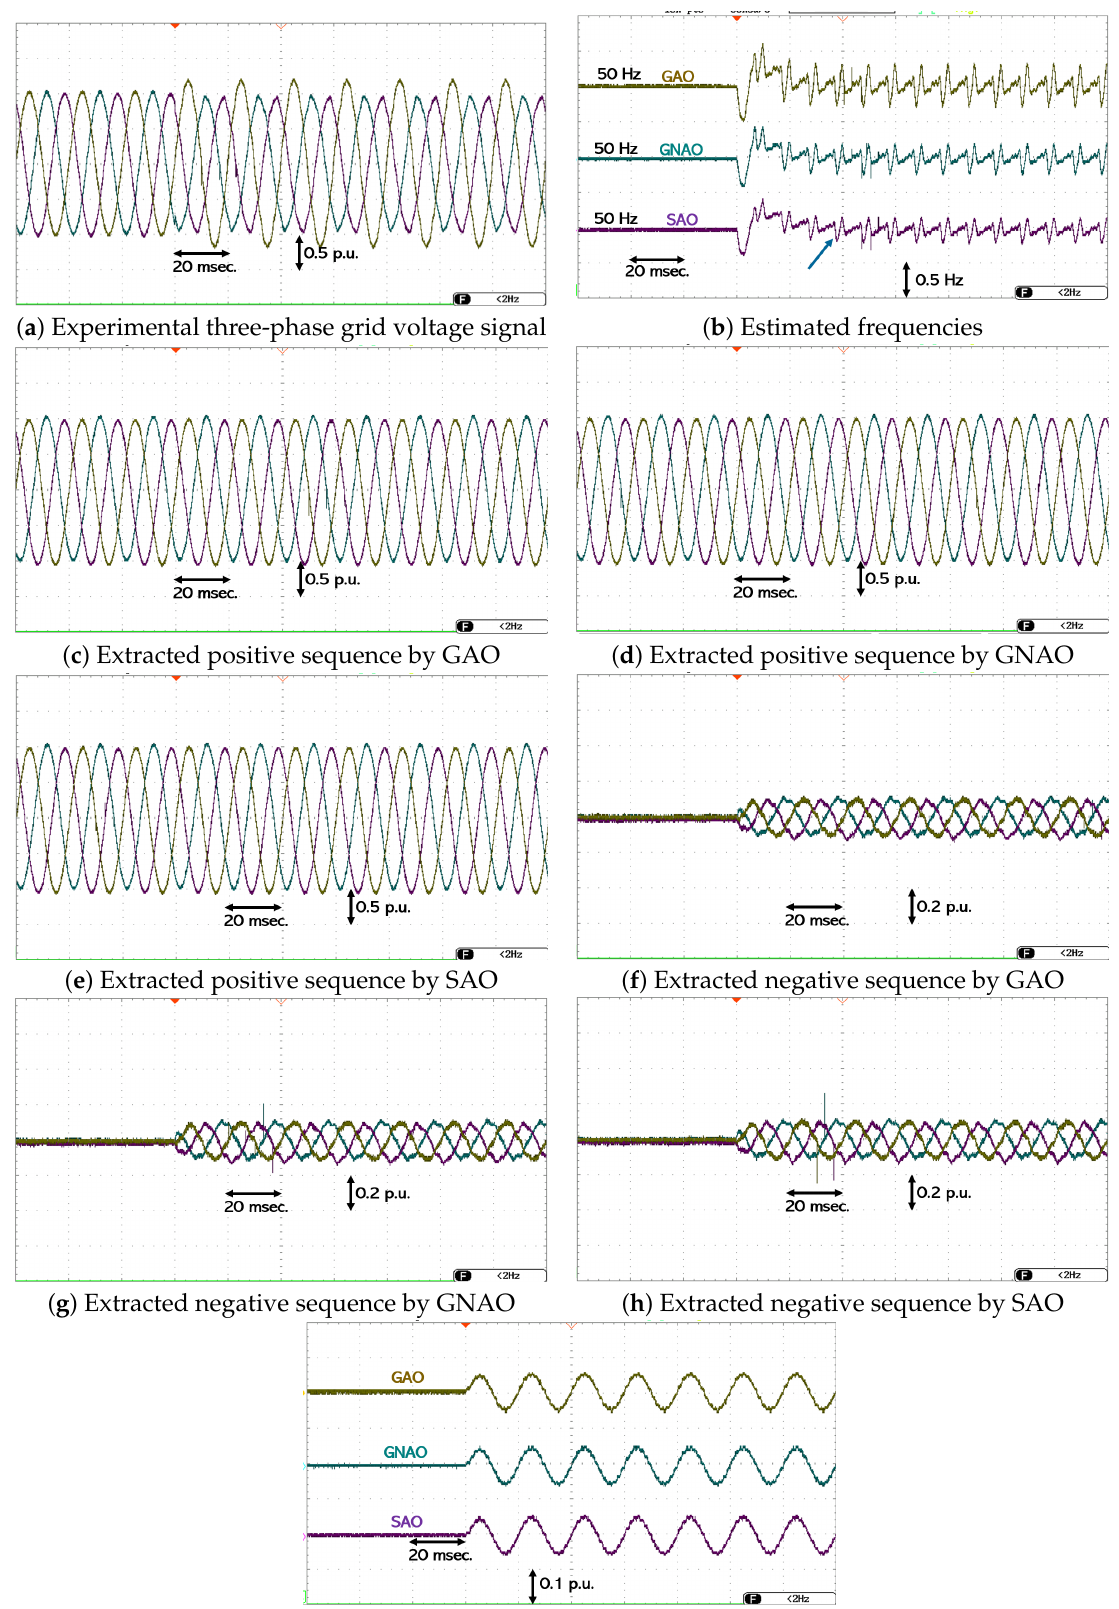
Figure 7. Experimental results for unbalanced and distorted